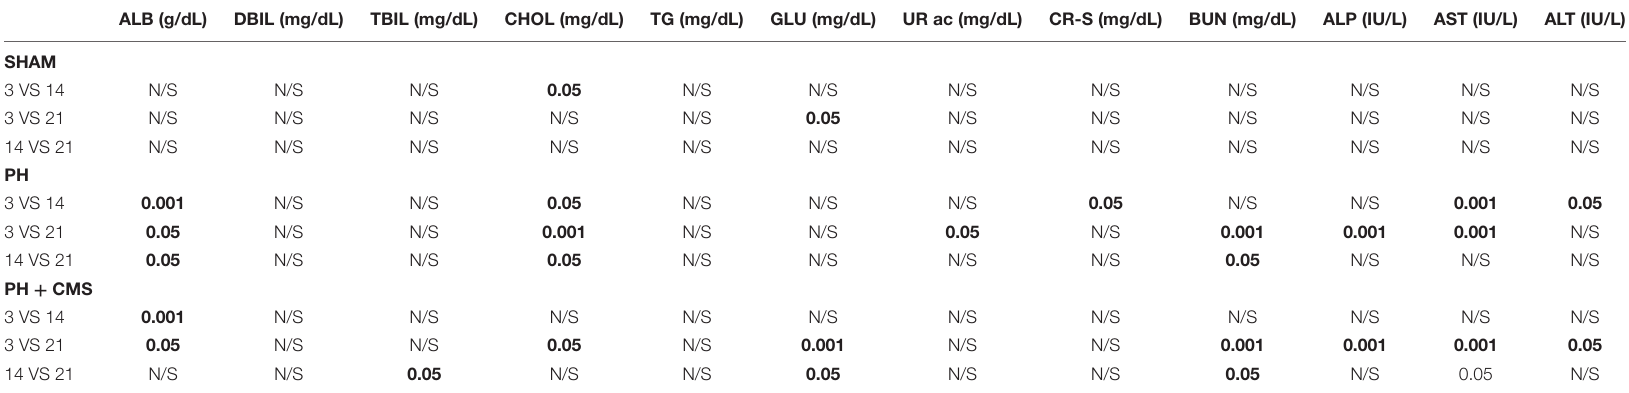
TABLE 2 | Intragroup comparison of the biochemical parameters.